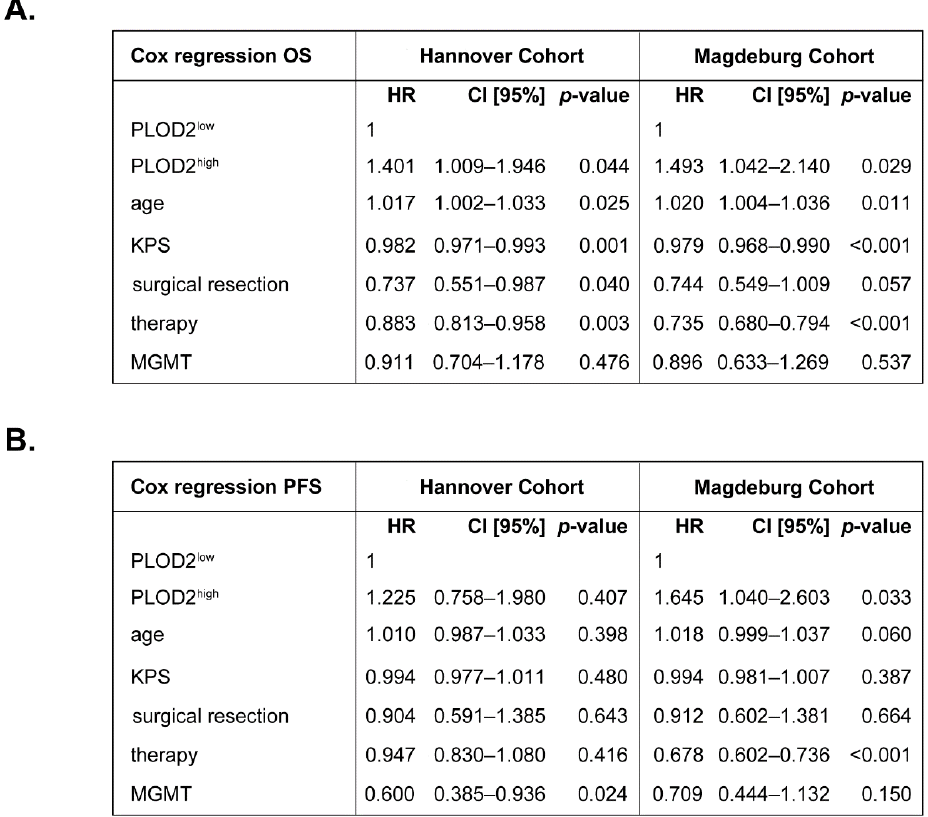
Figure 2. PLOD2 in GBM patients: multivariate analysis of survival. Multivariate Cox regression analysis model for the ( A ) overall survival (OS) and ( B ) progression-free survival (PFS) of patients with high versus low levels of PLOD2. HR: hazard ratio; CI [95%]: 95% confidence interval.